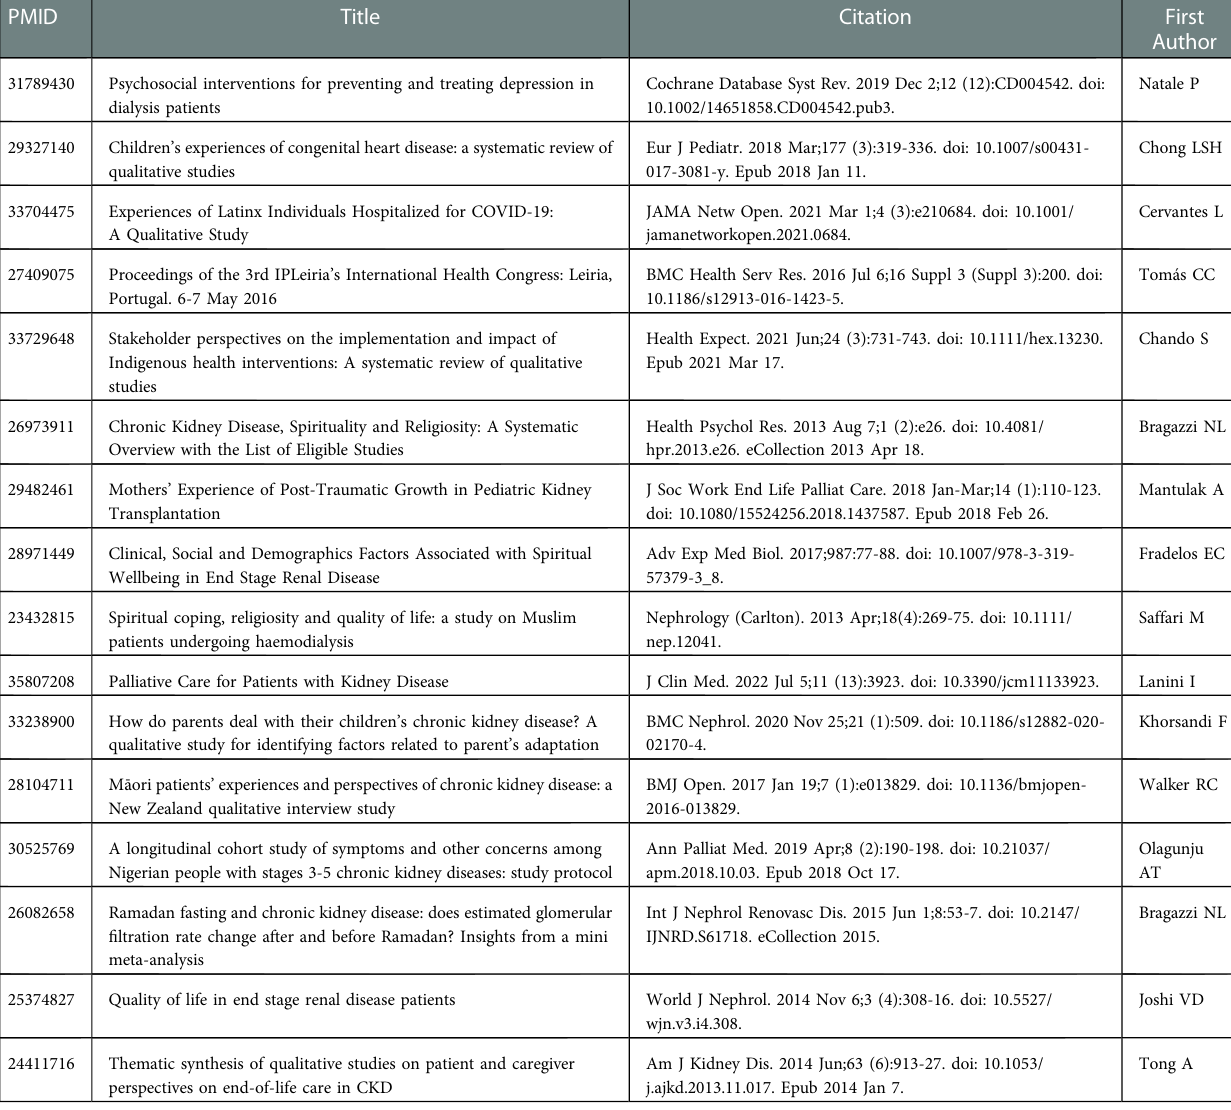
TABLE 1 November 21, 2022 at 11:11AM pubMed search not limited to English literature with terms (https://pubmed.ncbi.nlm.nih.gov/?term=spiritual +health%2C+spiritual+well-being+and+children+and+kidney).